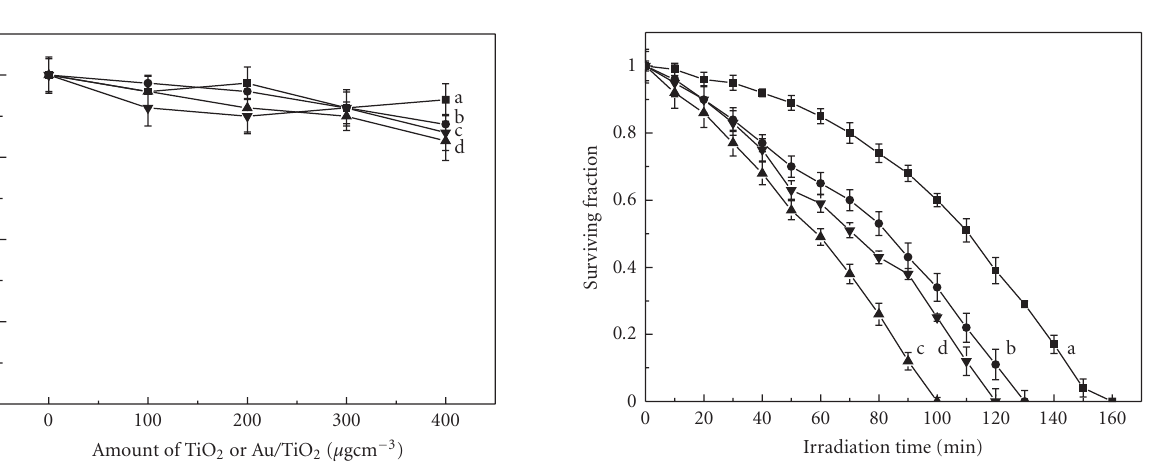
Figure 2: Surviving fraction of LoVo cells after being incubated in culture medium containing di ff erent amounts of (a) TiO 2 , (b) 1wt% Au / TiO 2 , (c) 2wt% Au / TiO 2 , and (d) 4wt% Au / TiO 2 in the dark for 24 hours. Bars represent the region of measured data and the points represent the mean value from three measurements.